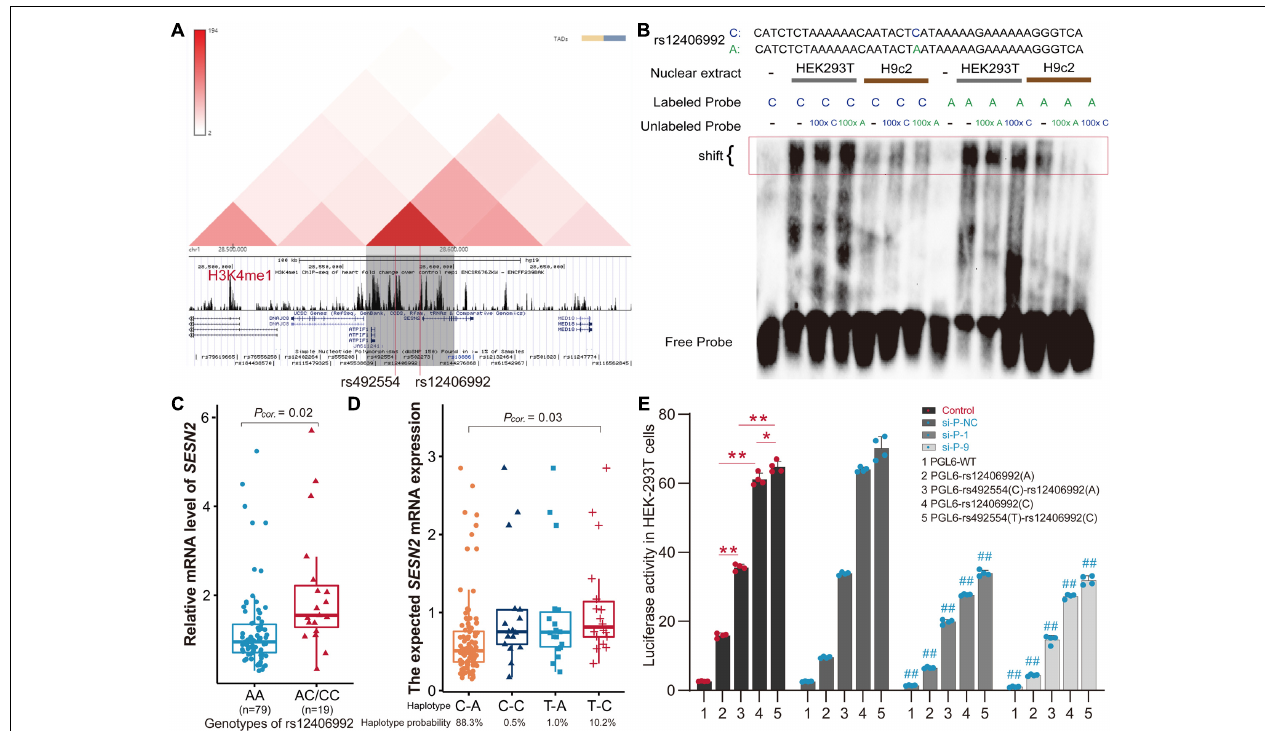
FIGURE 4 | The T-C haplotype of rs492554-rs12406992 specifically increases transcriptional activity. (A) Hi-C plots Hi-C chromatin interaction plots of human left ventricular tissue for the region surrounding the locus of rs492554 and rs12406992. (B) EMSAs were performed using biotin-labeled double-stranded oligonucleotides for the C and A alleles of rs12406992 and nuclear extracts from HEK293T cells and H9c2 cells. 100 × molar excess of unlabeled competitor was added in specified lanes. The rs12406992 C allele drives preferential protein binding. Blue 100 × refers to the C allele-containing probe. Green 100 × refers to the A allele-containing probe. (C) Relative mRNA expression levels of SESN2 in 98 myocardial tissues with rs12406992 genotypes. Gene expression data were analyzed by two-tailed unpaired Student t -test with Welch’s correction for unequal variances. (D) Association between the expected SESN2 expression and the haplotypes of rs492554-rs12406992. Expected gene expression data were analyzed by two-tailed unpaired Student t -test with Welch’s correction for unequal variances. Haplotype probabilities are indicated under each haplotype label. (E) The regions encompassing rs12406992 alleles with or without the linked rs492554 regions were cloned into the pGL6-Basic vector, and HEK293T cells were transfected. Luciferase activity was measured 48 h after transfection and was normalized against protein concentration. ** P < 0.001, * P < 0.01 against empty vector pGL6-WT are shown. The luciferase activity was significantly reduced in HEK293T cells co-transfected with POU2F1 small interfering RNA and the constructed luciferase reporter vectors. ## P < 0.001 against si-P-NC co-transfected with the corresponding luciferase reporter vector.